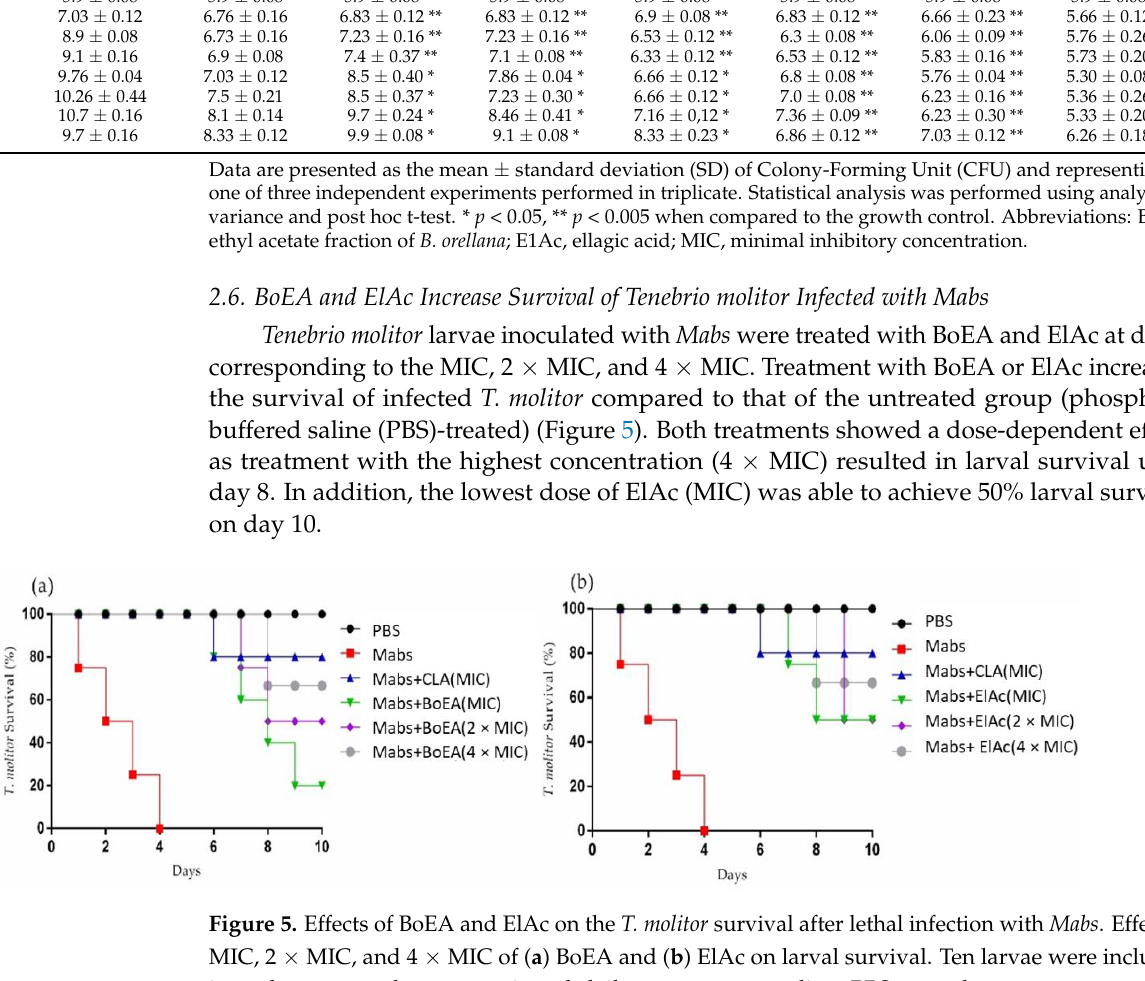
Table 9. Time – kill evaluation of Mabs with BoEA and ElAc. Clarithromycin concentration was used at MIC. Growth control: no compound was added to the cell suspension.